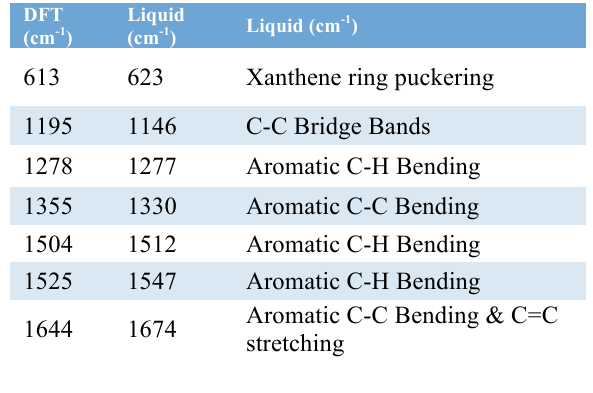
Tab. 1. Theoretical and experimental Rhodamine B